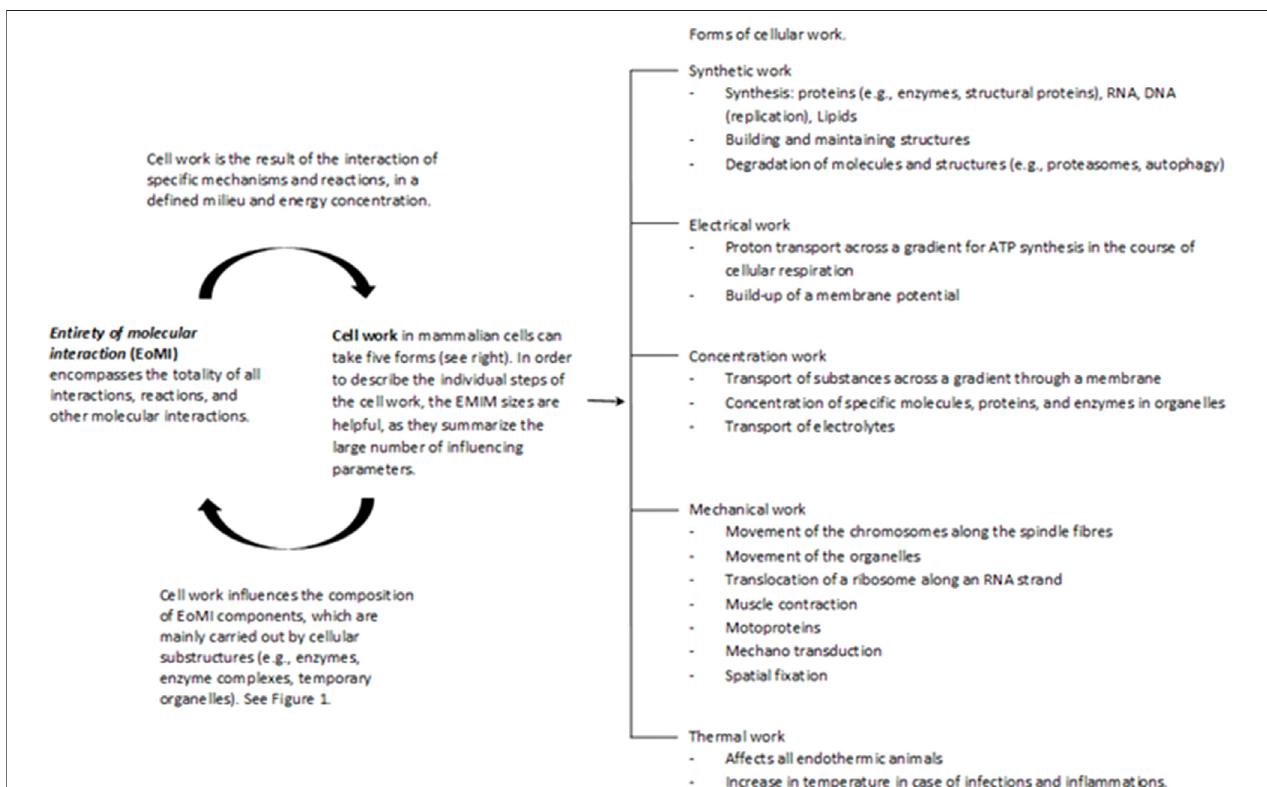
FIGURE 2 | The Entirety of molecular interactions (EoMi) is characterized by a large number of very different molecules and ions reacting with each other, forming equilibriumsand fl owequilibriums.Thesemechanismsaremarkedbyahighdegreeofdynamismandarecharacterizedbyself-organization.Theessentialdriverofthese processes is the fl ow of energy through which work/cell work emerges. This cell work can be divided into fi ve categories under which different work processes can be grouped(see fi gure).WhatisinterestinginthiscontextisthattheEoMIproducescellworkthroughself-organizationandthattheseinturnin fl uencethecomposition of the EoMi through the various work processes. Cell work is an emergent property of EoMi. The various forms of cell work can come together to form superordinate systems that exhibit new emergent properties, which in turn in fl uence the system (see also Figure 1 ).